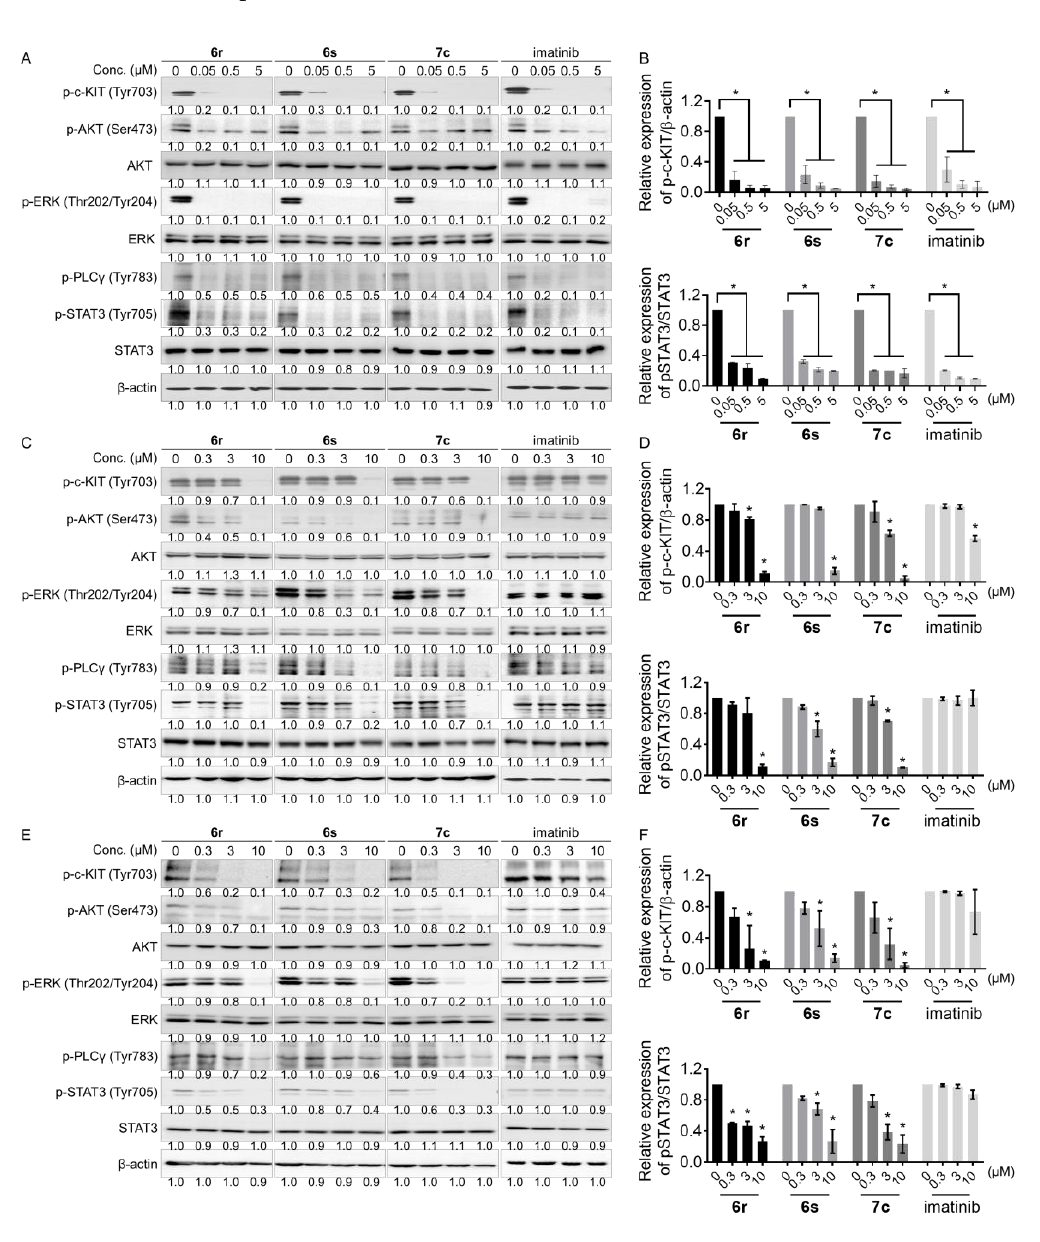
Figure 4. c-KIT and its downstream signaling are inhibited by 6r , 6s , and 7c in ( A , B ) GIST-T1, ( C , D ) HMC1.2, and ( E , F ) c-KIT D816V Ba/F3 cells. Quantification of phosphorylated c-KIT and STAT3 levels by the treatment of 6r , 6s , and 7c in GIST-T1, HMC1.2, and c-KIT D816V Ba/F3 cells. (average ± S.D., n = 3 one-way ANOVA; * p <